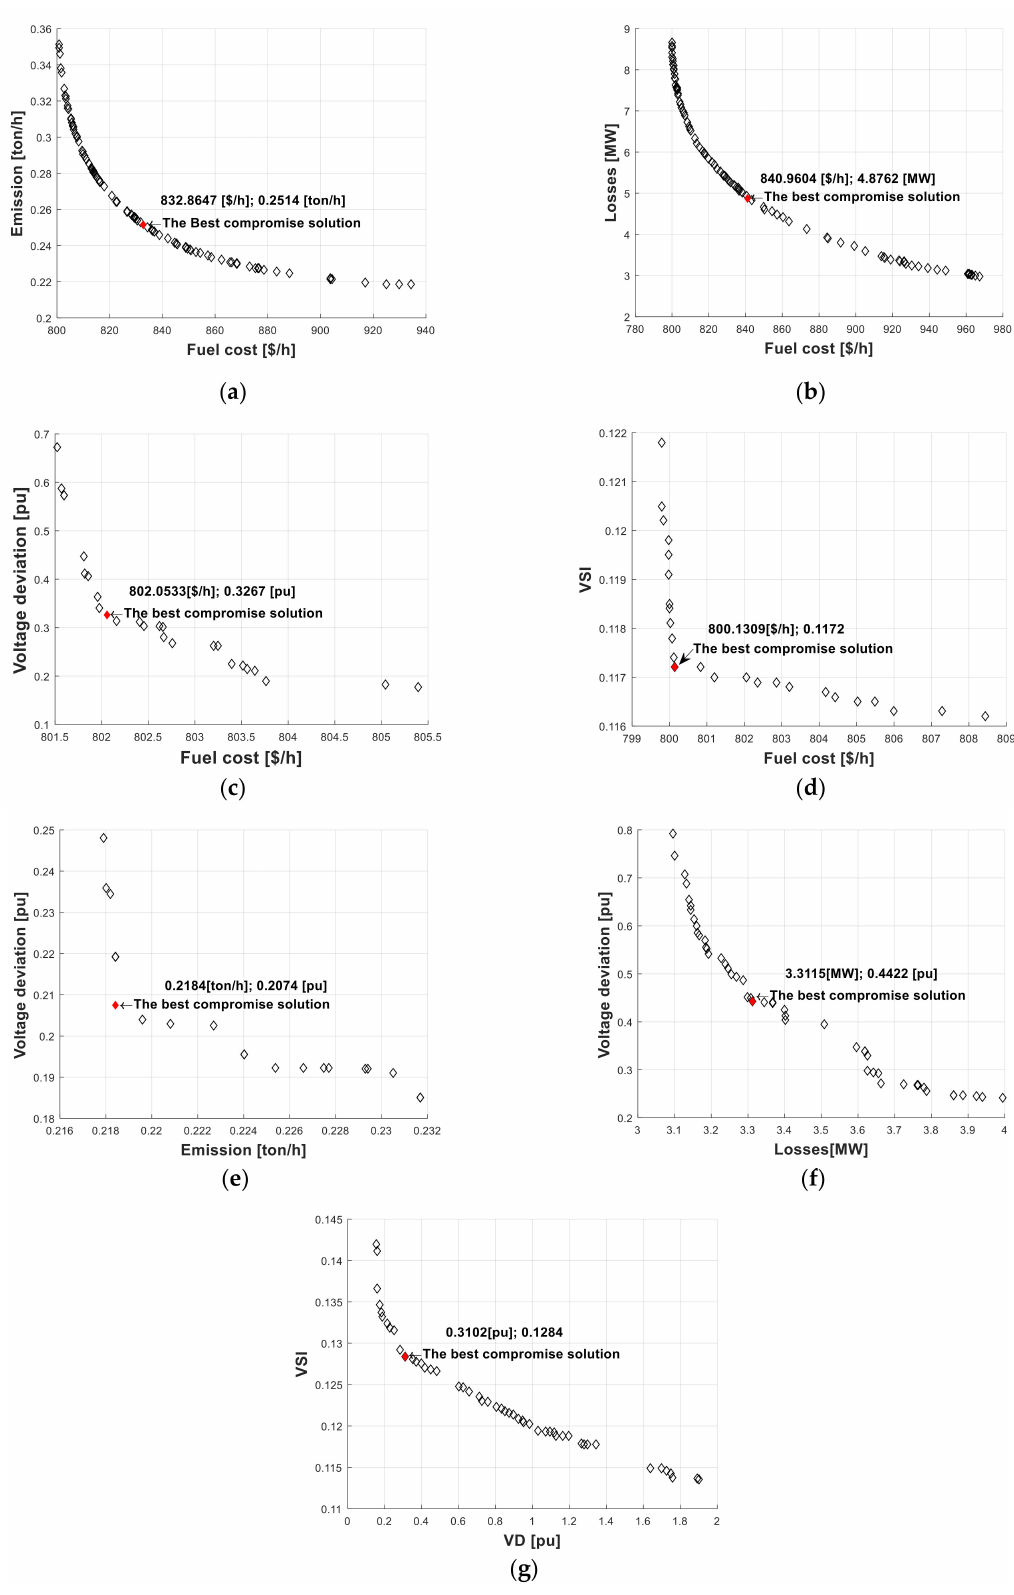
Figure 6. The convergence characteristics of the MOSMA algorithm for Cases 6–12. ( a ) Case 6, ( b ) Case 7, ( c ) Case 8, ( d ) Case 9, ( e ) Case 10, ( f ) Case 11, ( g ) Case